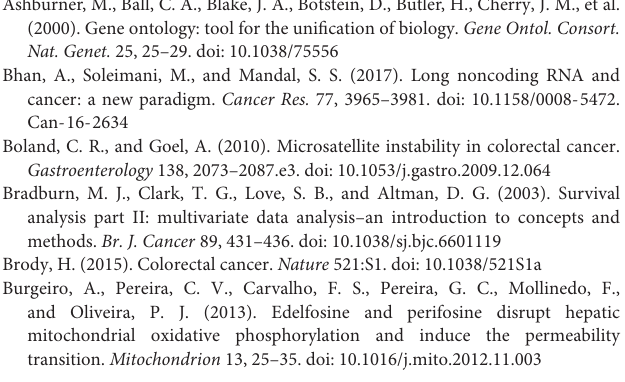
the expression of each miRNA and its paired lncRNAs based on ENCORI. (C) Correlation between the expression of each miRNA and its paired mRNAs based